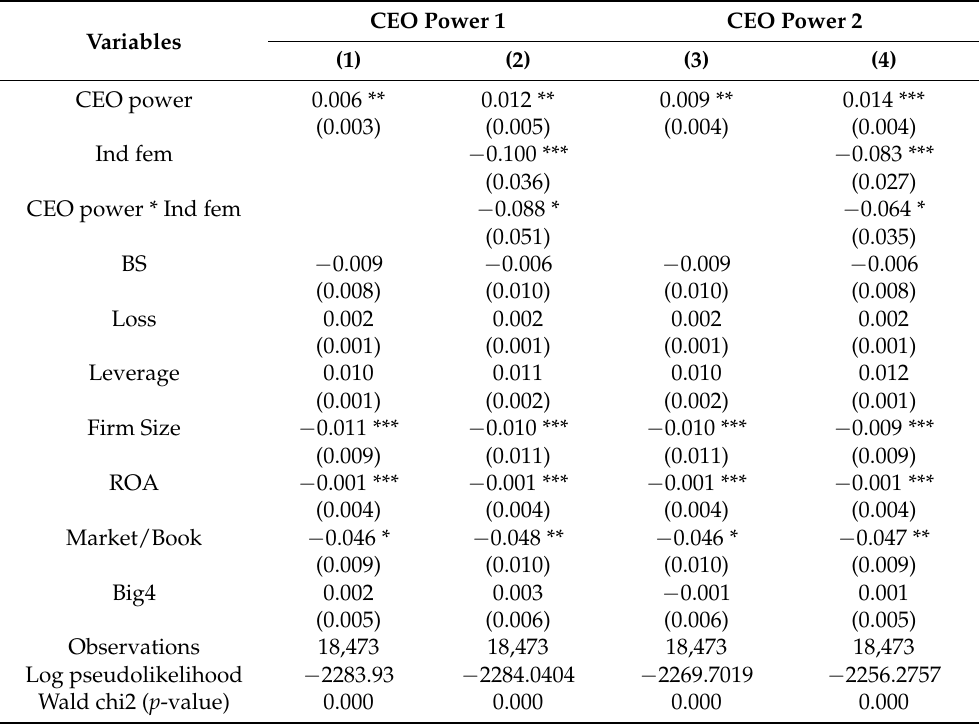
Table 7. The moderating effect of independent female directors on CEOs power and financial fraud (marginal